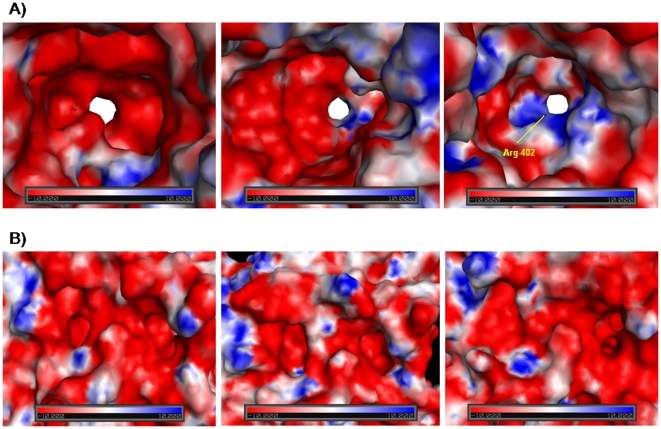
Electrostatic charge distribution of POP of three species.
a) down the β-propeller pore view of electrostatic potential. Three species showed differences in electrostatics. A. thaliana POP showed more positive potential; similarly differences were also present in human and porcine POP proteins b) Electrostatic potential of inter-domain cavity and recently reported cavity (Tarrango et al 2009). In A. thaliana later cavity was hidden.